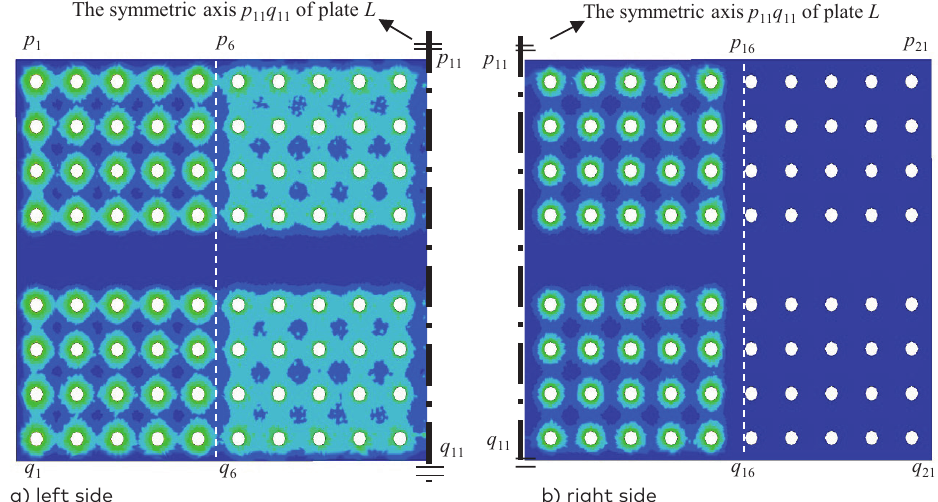
a) left side Figure 10. The interface pressure on the two sides of splice plate